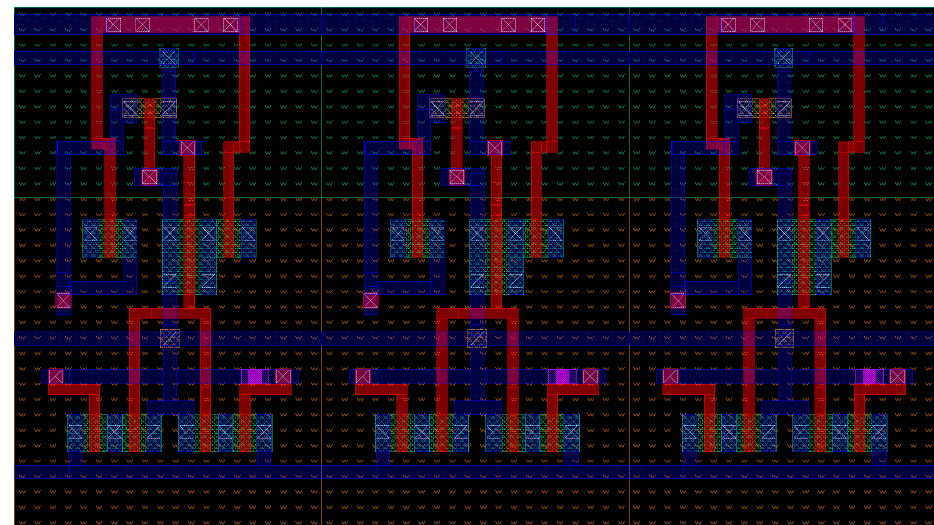
Figure 4. A layout section of the dummy line for the CAM